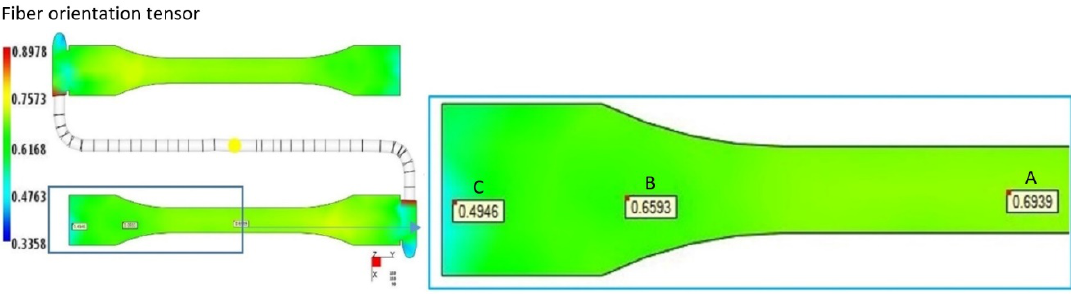
Figure 7. Tensor a 11 value in selected zones of the mold cavity.